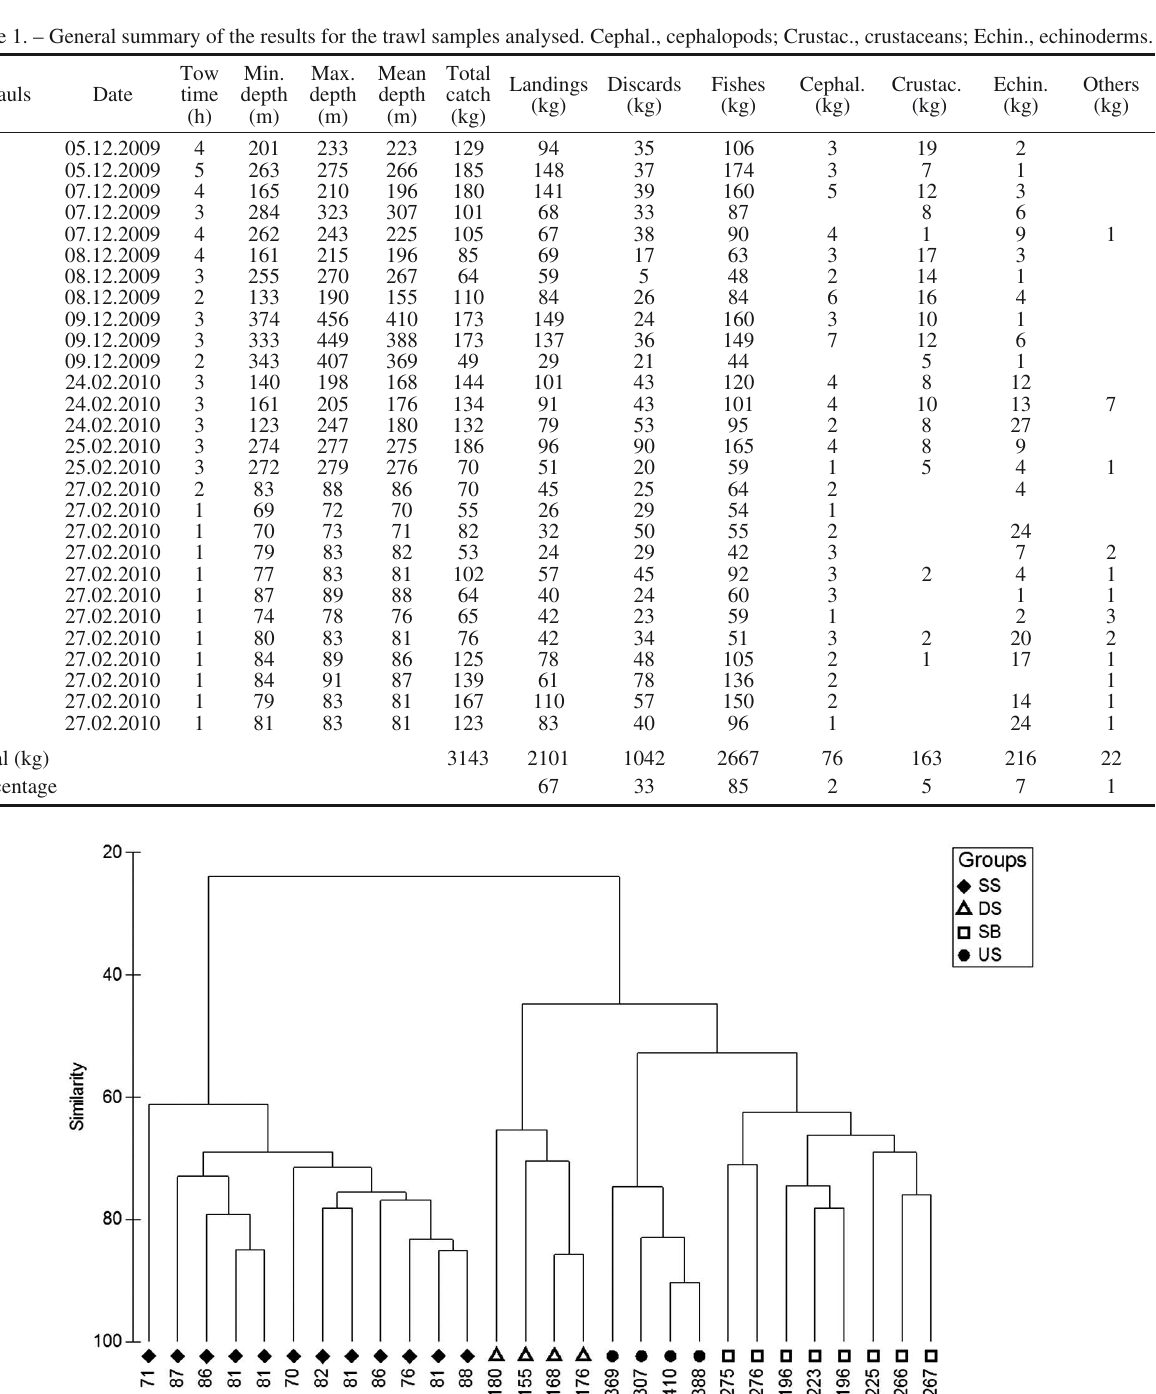
Fig. 2. – Cluster analysis of the species abundance (individuals/h) in the trawl samples . Mean depth is shown for each sample. SS, shallow shelf; DS, deep shelf ; SB, shelf break; US, upper